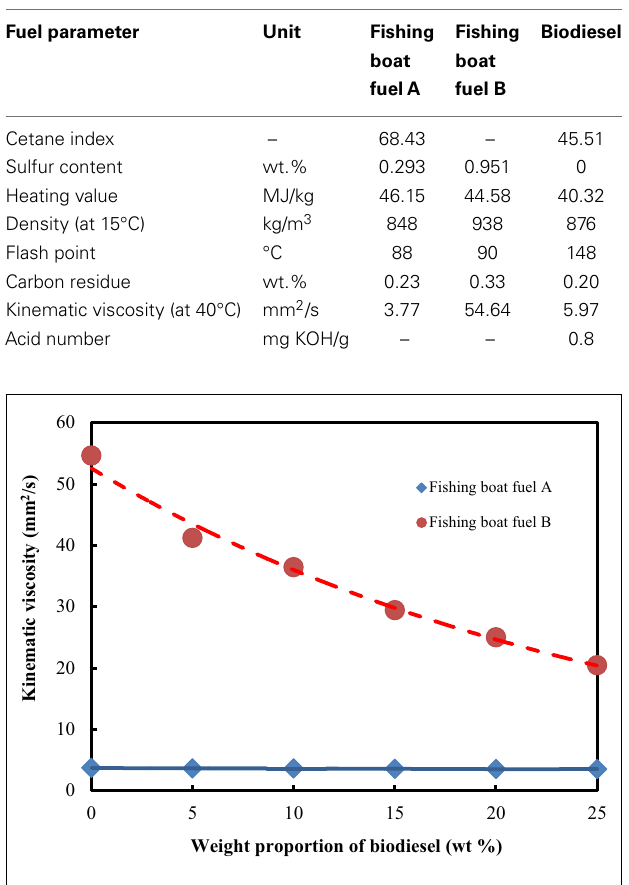
whereas fuel A is a distillate fuel with properties similar to those of ASTM No. 2D